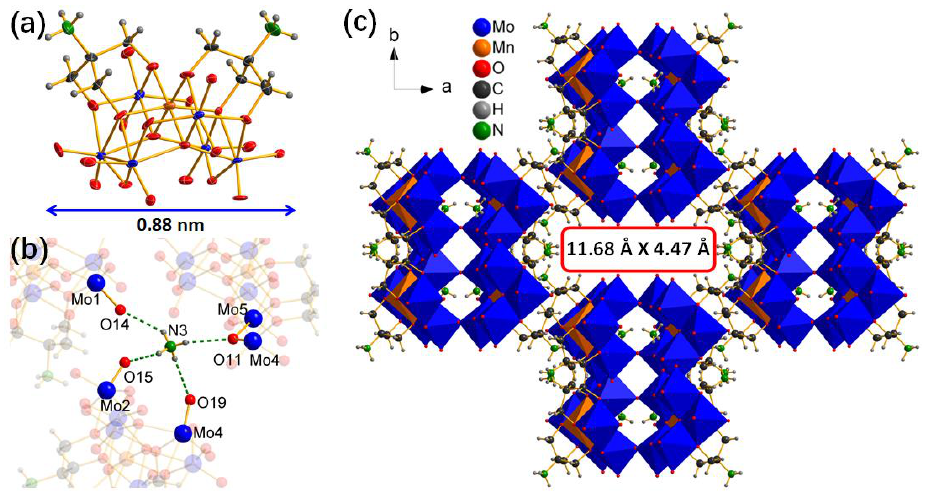
Figure 1. Structures of catalyst 1 . ( a ) ORTEP drawing of nanocluster 1 (30% probability ellipsoid); ( b ) Hydrogen bonding interactions between NH 4+ and nanocluster 1 ; ( c ) The crystal structure of catalyst 1 packing along c axis.